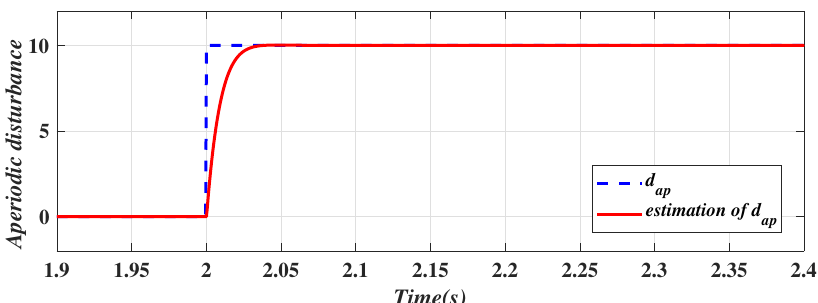
Figure 4. Aperiodic disturbance and estimation of aperiodic disturbance.